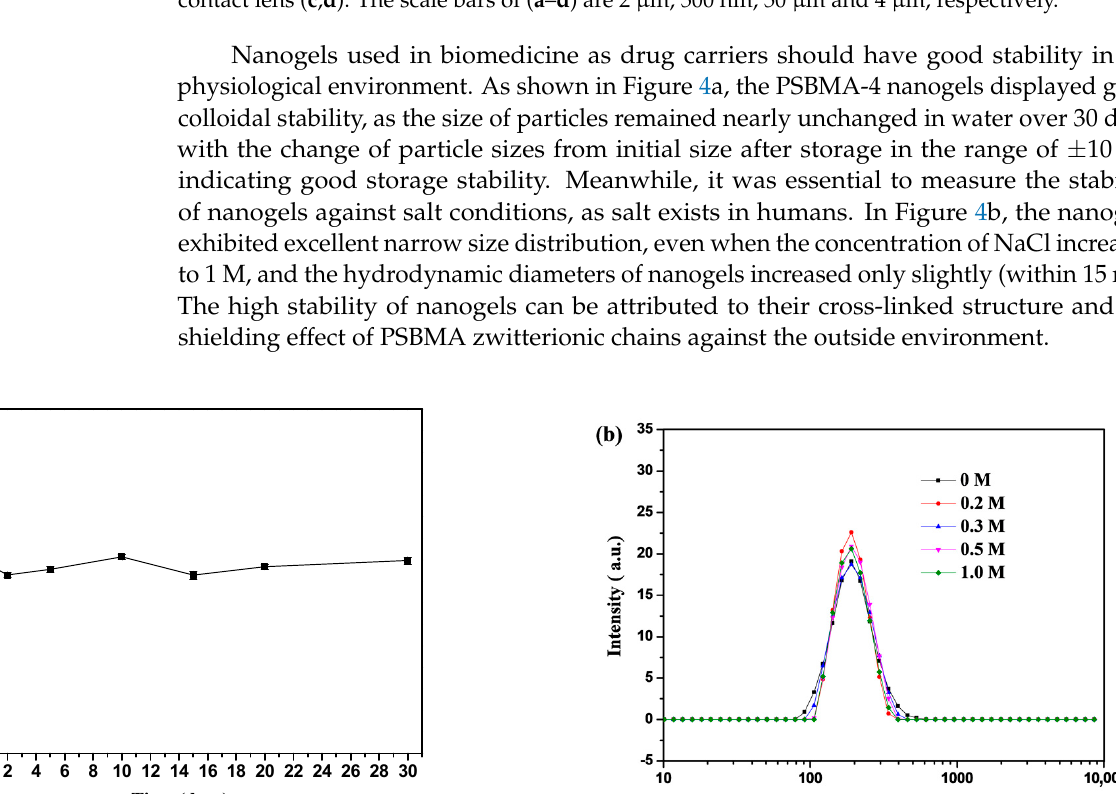
Figure 3. SEM images of the PSBMA-4 nanogel ( a , b ) and surface of freeze-dried nanogel-embedded contact lens ( c , d ). The scale bars of ( a – d ) are 2 μm, 500 nm, 50 μm and 4 μm, respectively.